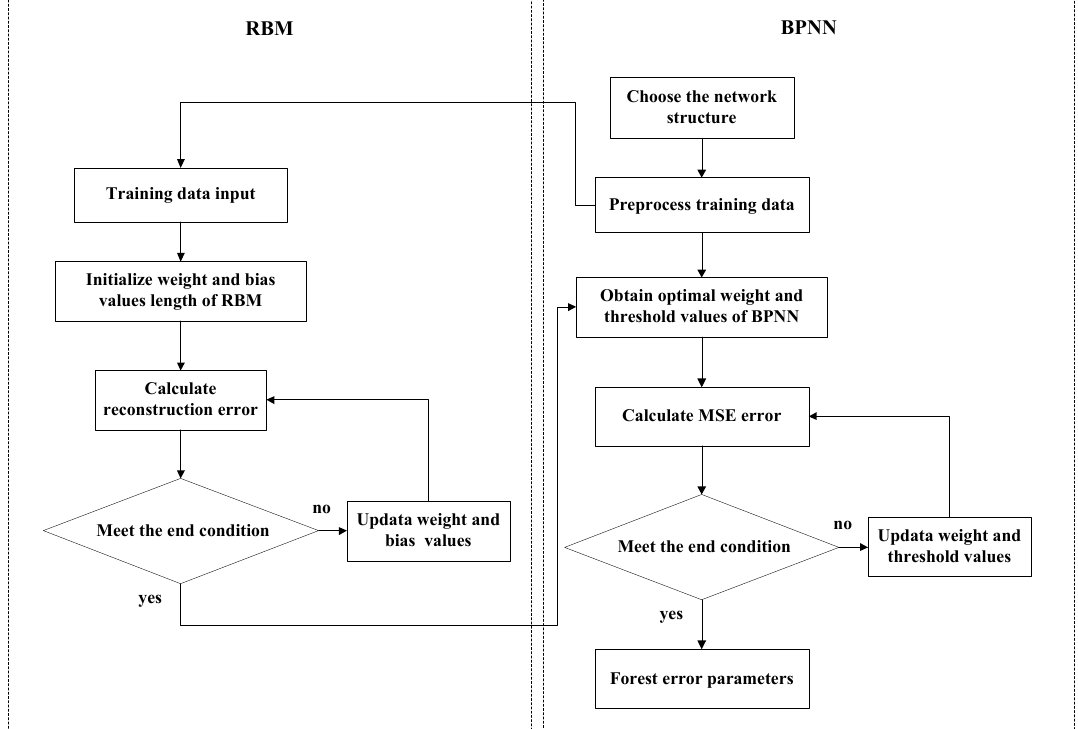
Figure 6. Training flow chart of